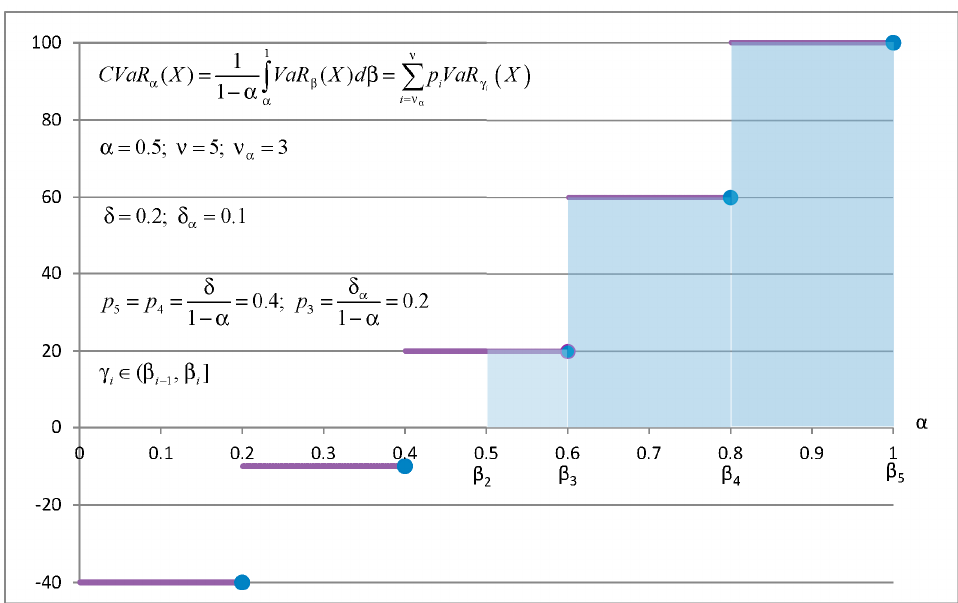
Figure 1. Five equally probable atoms. VaR and CVaR with Set 1 of parameters for 𝛼 = 0.5.